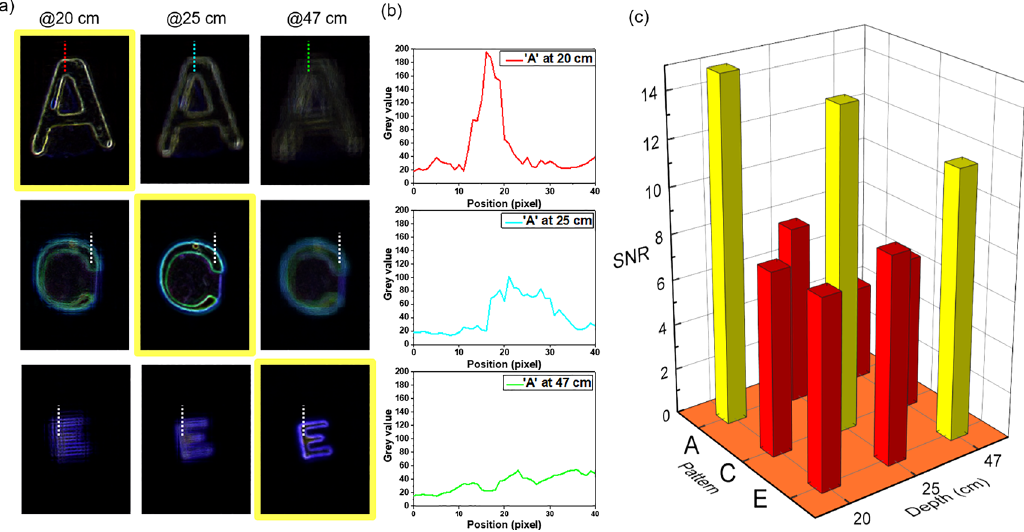
Figure 4: Edge sharpness measurement results of the 3D edge imaging at various depths. (a) The cut-line of the edge sharpness measurement for the SNR calculation. All the dotted lines (red, cyan, green, and white) are the selected regionsfortheSNRcalculation.Renderedimagesinthesamecolumnarefocusedwithdepthsof20cm,25cm,and47cm,respectively.(b)The edge pro fi les of pattern ‘ A ’ whose rendered images are focused with depths of 20 cm, 25 cm, and 47 cm. The color of the curve corresponds to the color of the dotted cut-line in (a). The edge pro fi les of the pattern ‘ C ’ and ‘ E ’ are shown in Figure S9 of Supplementary material. (c) The diagram of the measured SNR of the three patterns with three rendering